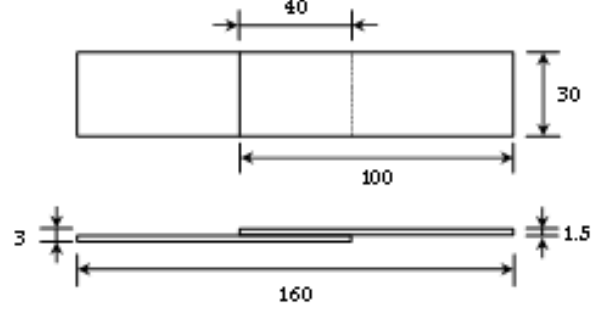
Figure 2. Dimensions of Al 1050 strips. Table 1. Chemical composition of Al 1050.